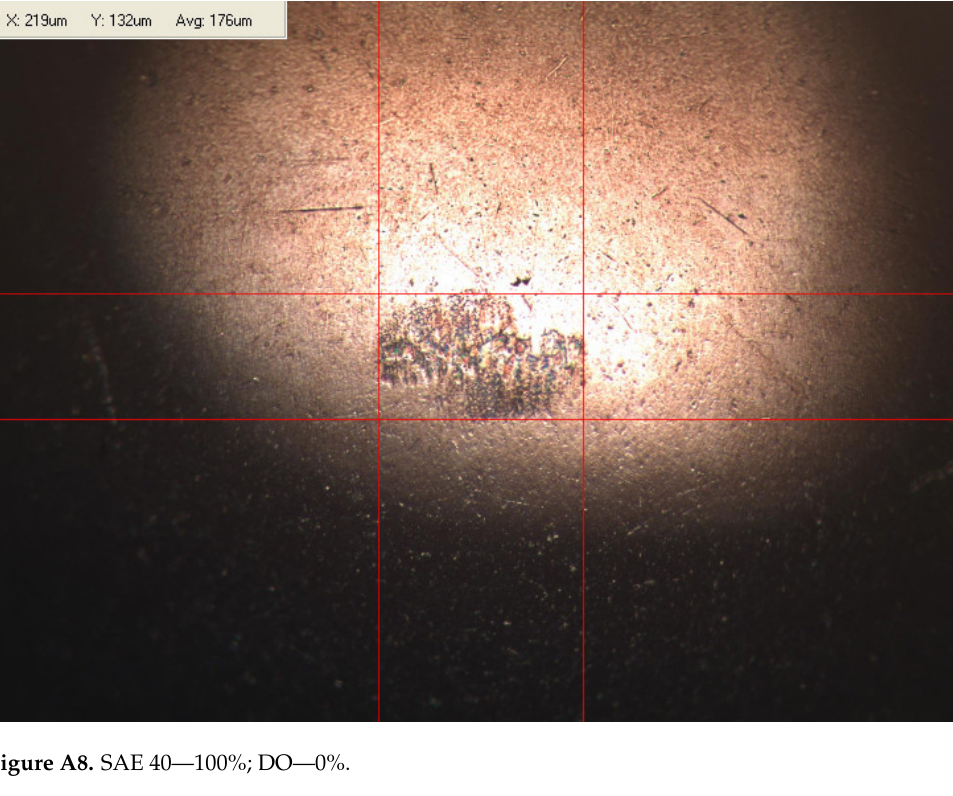
Figure A7. SAE 30—50% m/m; DO—50% m/m.